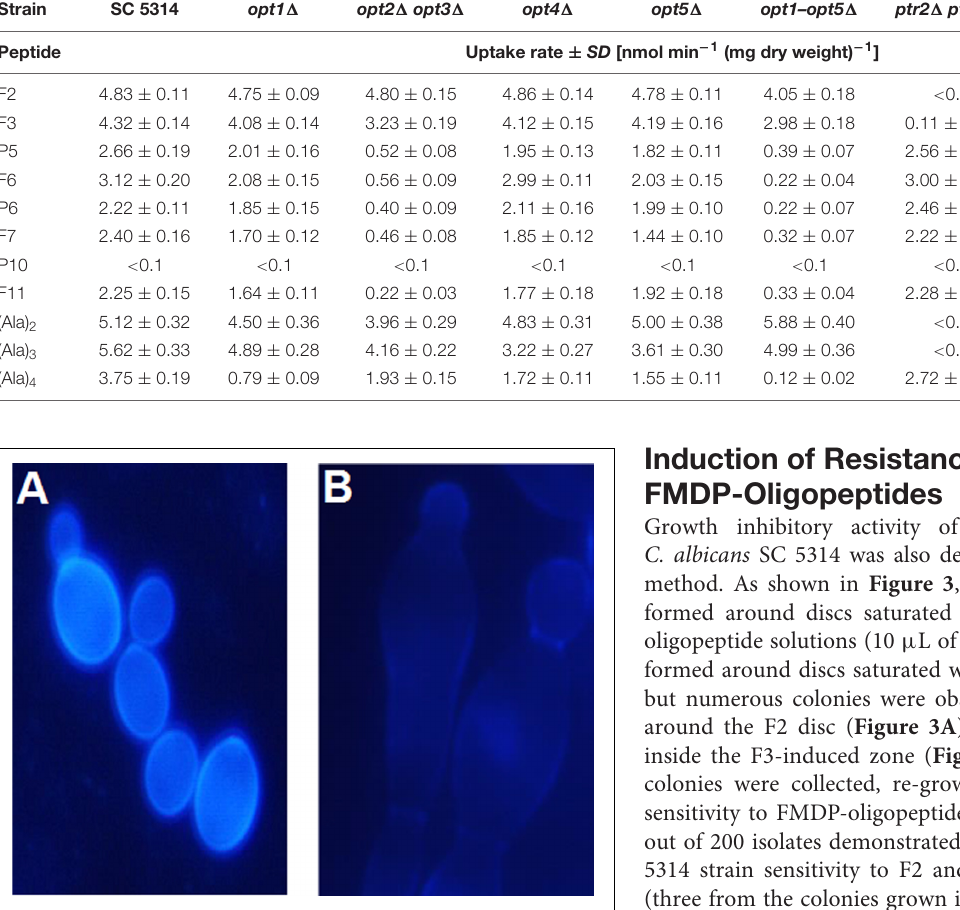
The cells were stained with Calcofluor White, the